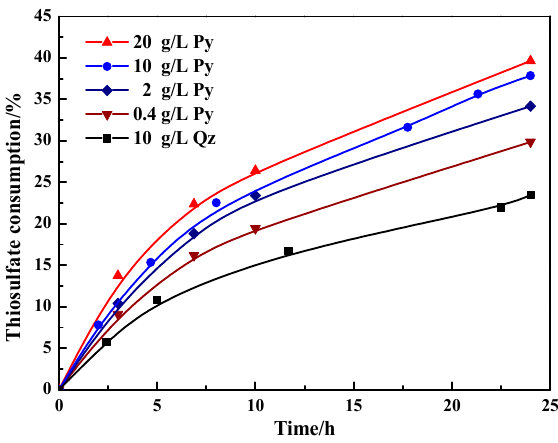
Figure 3. Variation of the thiosulfate consumption with time during thiosulfate leaching of gold in the presence of pyrite and quartz. Mineral content: 0.4, 2, 10 and 20 g/L pyrite; 10 g/L quartz.